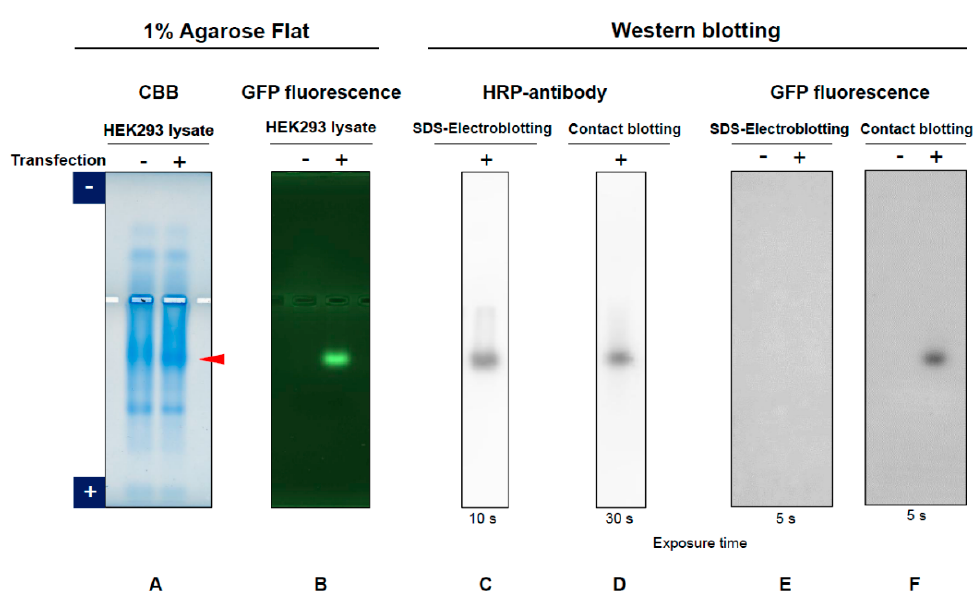
Figure 13. Comparison of SDS-electroblotting and contact blotting. In this blotting, PVDF membrane was placed only at the bottom side for contact blotting (pattern A in Figure 11) and at the anode side for SDS-electroblotting (semi-dry condition). ( A ) CBB staining of HEK293 cell lysates expressing GFP (+ lane). ( B ) GFP fluorescence on agarose gel. ( C ), GFP protein detected by HRP-conjugated antibody on SDS-electroblotting. ( D ) GFP protein detected by HRP-conjugated antibody on contact blotting. ( E ) GFP fluorescence on SDS-electroblotting. ( F ) GFP fluorescence on contact blotting.